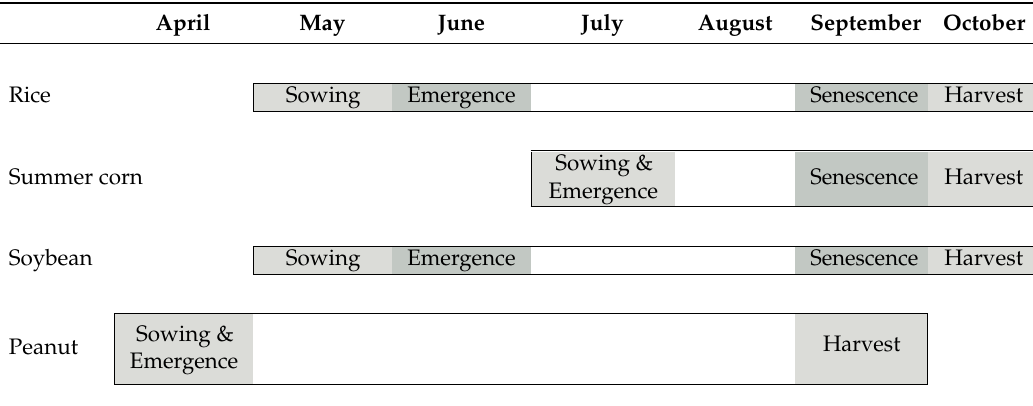
Table 1. Growth duration of summer crops in Jiangsu